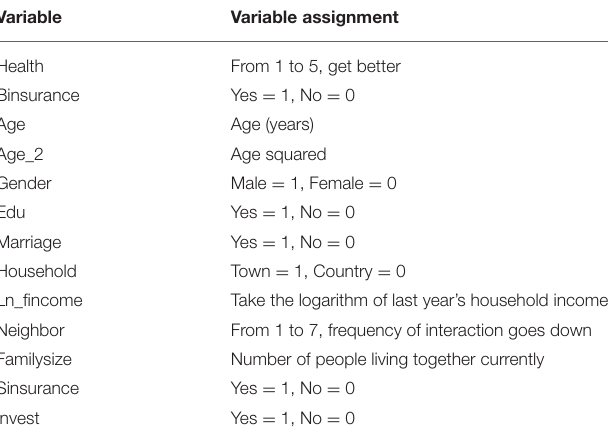
TABLE 1 | Variable definition and assignment.